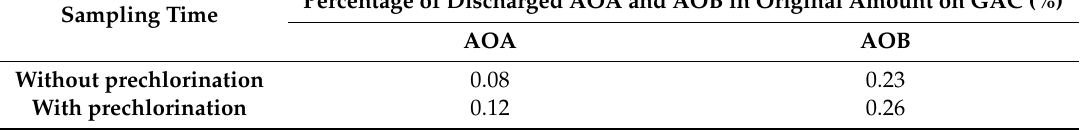
Table 2. Percentage of the discharged AOA and AOB in the backwashing water as compared with the original amounts on the